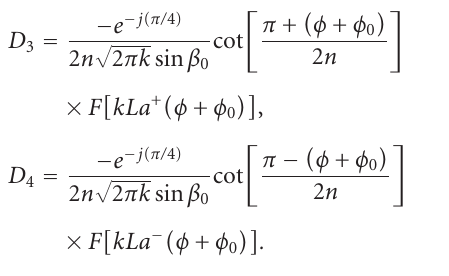
Figure 7: Computation chart of the channel response to a wideband